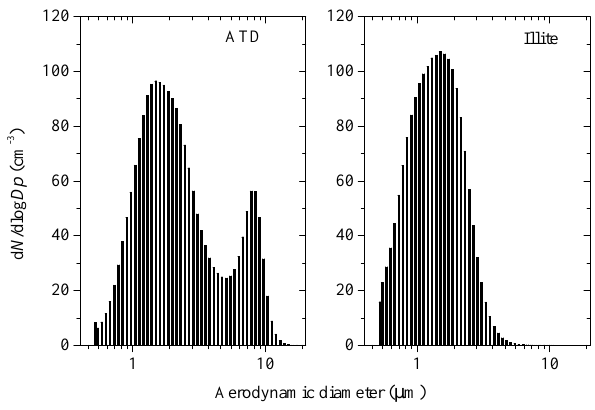
Fig. 2. Typical size distribution of ATD and illite particles measured at the downstream end of the aerosol flow